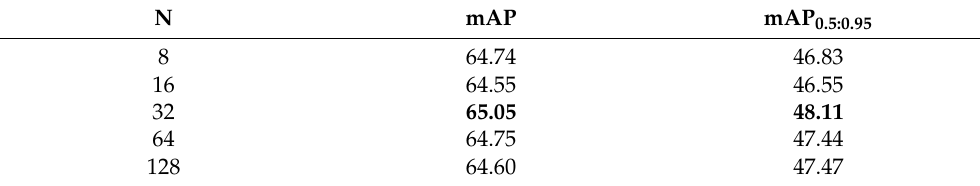
Table 4. Result of varying the number of RGB value interval divisions .